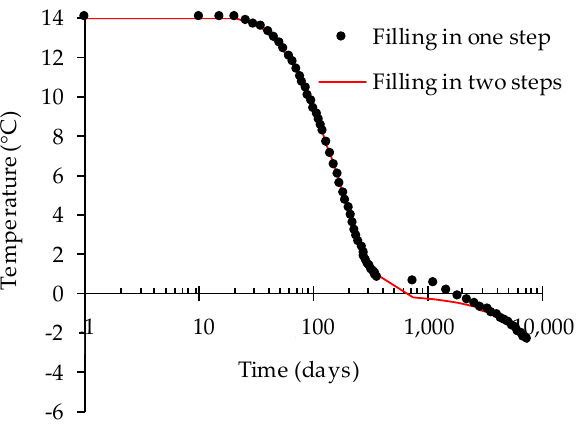
Figure 12. Comparison of temperature evolution at the center of the CPB for one-step backfilling (instantaneous) and two-step backfilling (instantaneous plug + instantaneous residual filling).